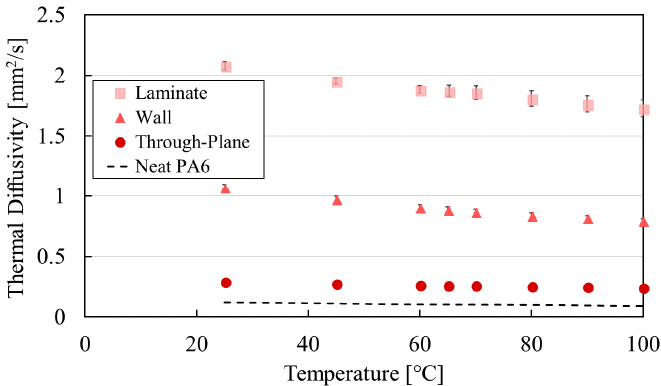
Figure 9. The thermal diffusivity decreases with temperature in the 20% vol copper fiber material. Standard deviations are imperceptibly small in most cases.